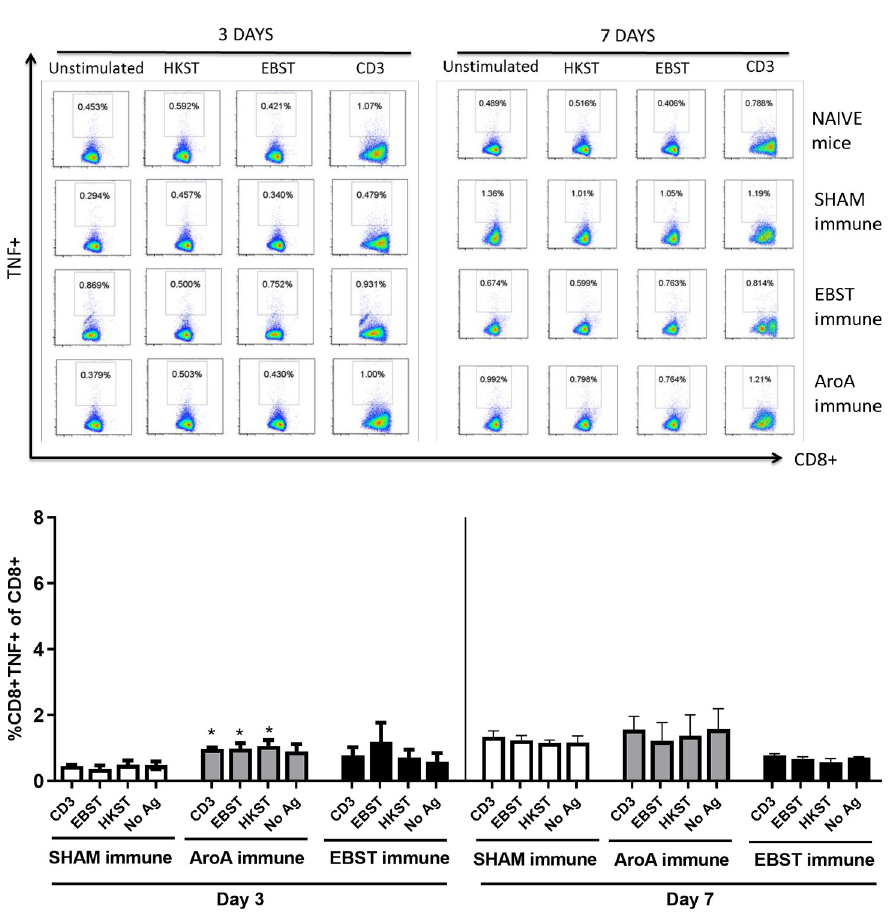
Fig 10. Salmonella specific CD8+TNF+ T cell responses in EBST, Live ST and Sham mice during virulent ST challenge. Individual EBST immune, AroA immune, and Sham immune mice were infected with virulent ST and at 3 days and 7 days post infection splenocytes were measured for production of TNFa by antigen specific CD8+ T cells using intracellular cytokine staining (ICS). Antigens used were EBST and HKST (2 x10 7 cells/ well) and anti-CD3 antibody as positive control. Unstimulated splenocytes were included as control. Percentages in the gated region of dot plots indicate the proportion of CD8+TNF+ of total CD8+ splenocytes (Fig 10A). The data represents three-five individual mice per group. The bar graph represents mean ± SEM of 3–5 mice per group. Y axis represents percentage of CD8+TNF+ of total CD8+ splenocytes (Fig 10B) on days 3 and 7. Statistics were determined for comparisons between group for each antigen at the indicated day. � , p �